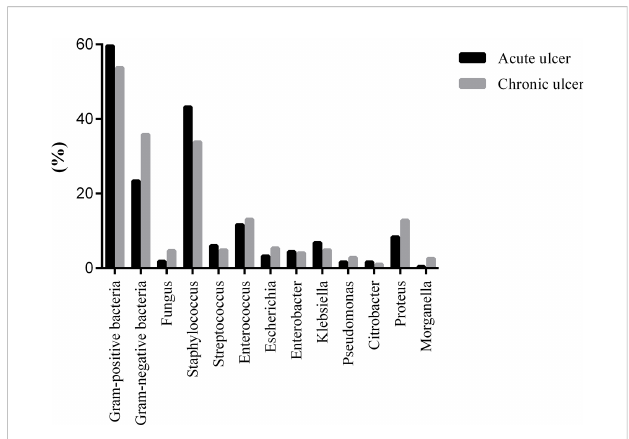
FIGURE 1 The distribution of pathogenic bacteria was detected in DFI with different duration of ulcer.